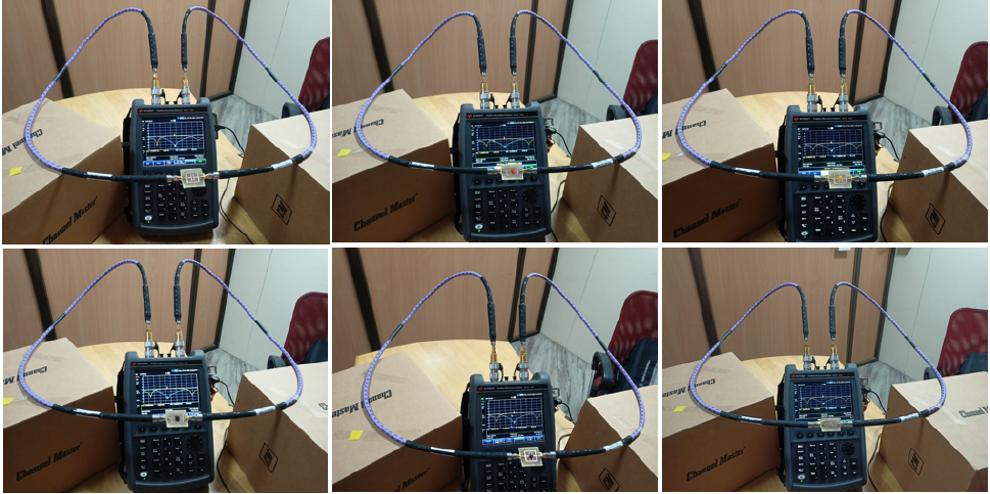
Figure 22. Senor testing in solid samples.